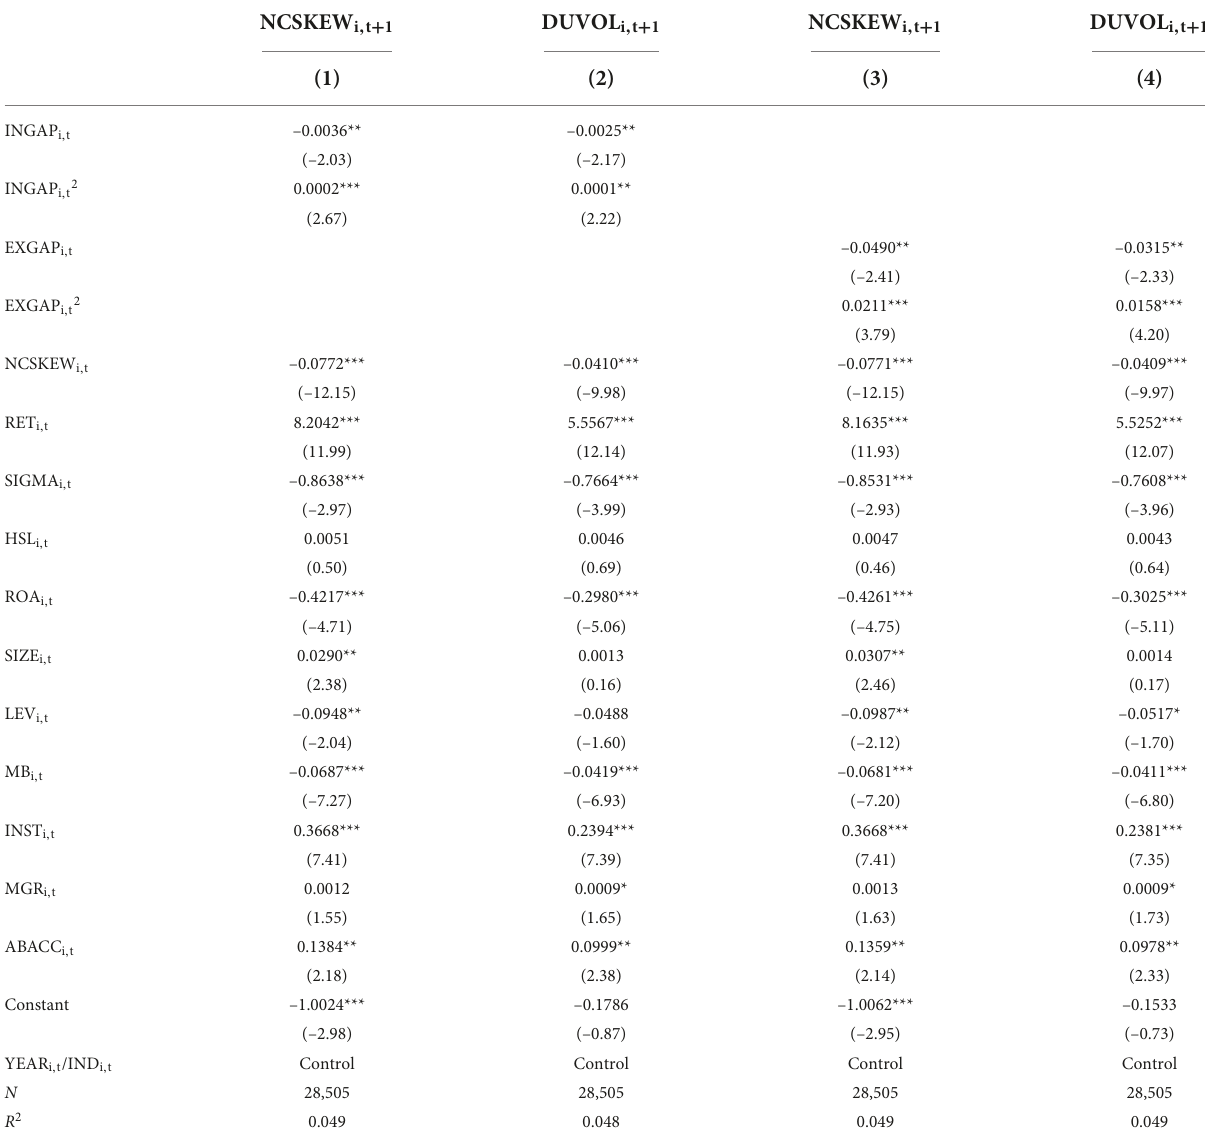
TABLE 3 Regression analysis to pay gap and stock price crash